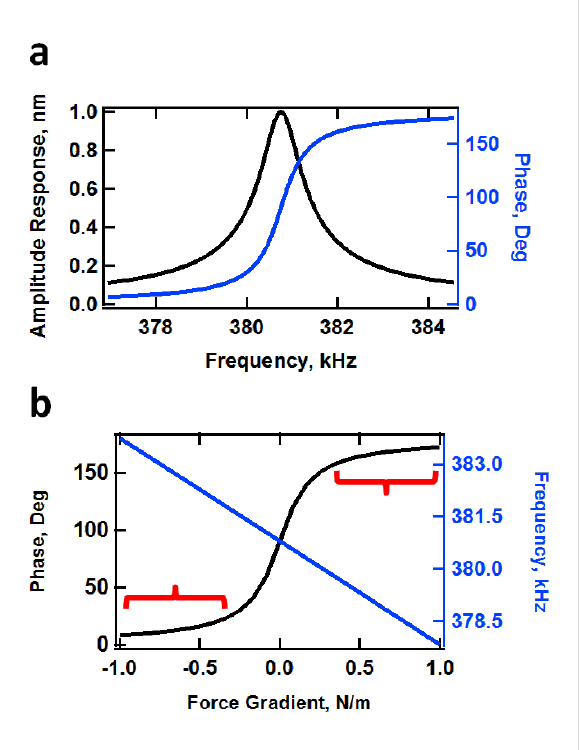
Figure 4: Illustration of the ideal response of a harmonic oscillator [22]. (a) Amplitude and phase vs excitation frequency (at the resonance frequency the phase is 90 degrees); (b) phase and effective frequency shift vs external force gradient (at zero force gradient the phase is 90 degrees and the frequency is equal to the resonance frequency). In general, the force gradient becomes more negative (the force curve becomes steeper in the repulsive region) as the tip–sample indenta- tion increases, leading to lower phase values. The red brackets in (b) indicate regions of low contrast, where the phase response is rela- tively flat with respect to changes in the force gradient. Measurements under these conditions lead to lower quality contrast in the